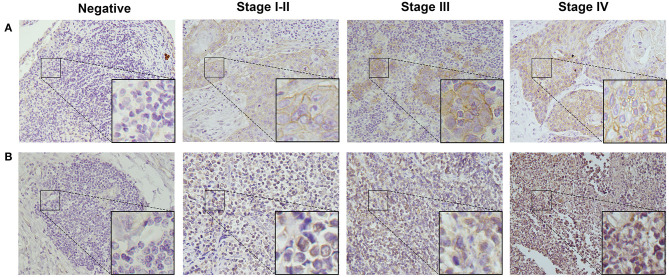
Representative images comparing CD155 (A) and TIGIT (B) expression in tumor and matched adjacent tissues (original magnification ×400).